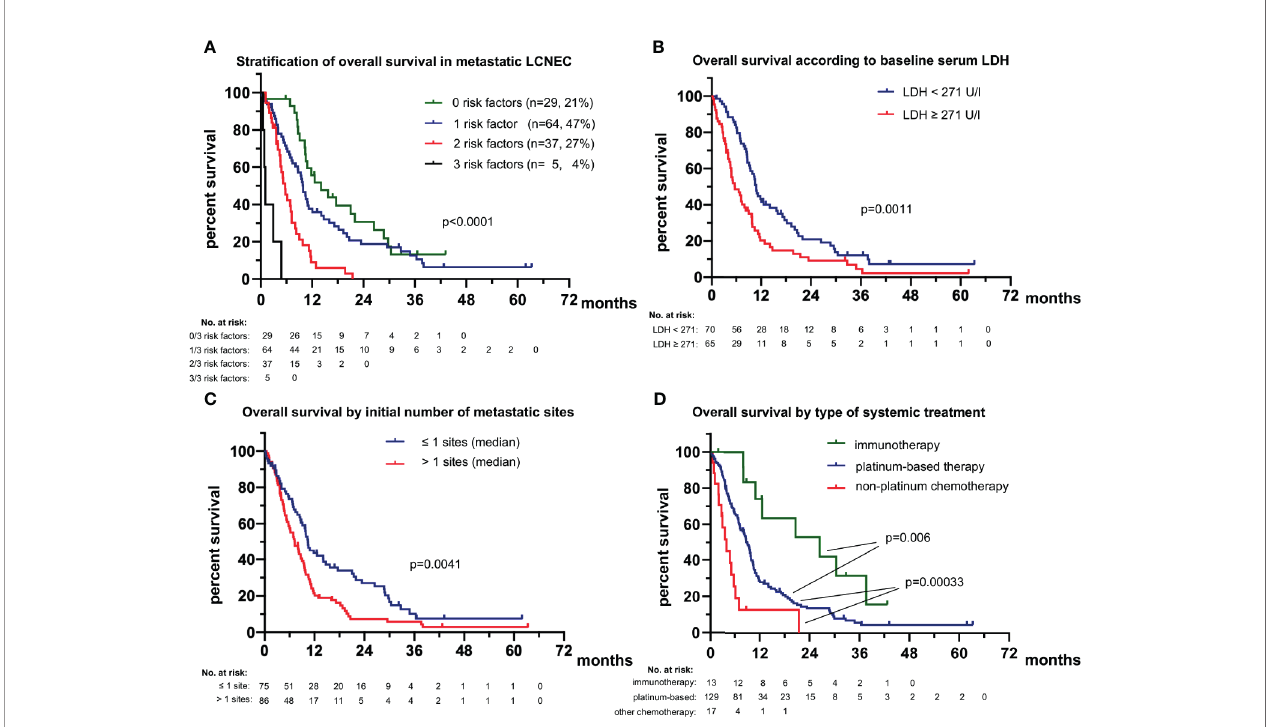
Figure 6A ), and a worse ECOG PS (68% vs. 48% for ECOG ≥ 1 vs. ECOG 0, chi-square p=0.036, Figure 6B ). Along the same lines, the total number of chemotherapy lines administered to each patient correlated negatively with the baseline serum LDH levels (r=-0.22, p=0.03) and the ECOG PS at initial diagnosis (r=-0.20, p =